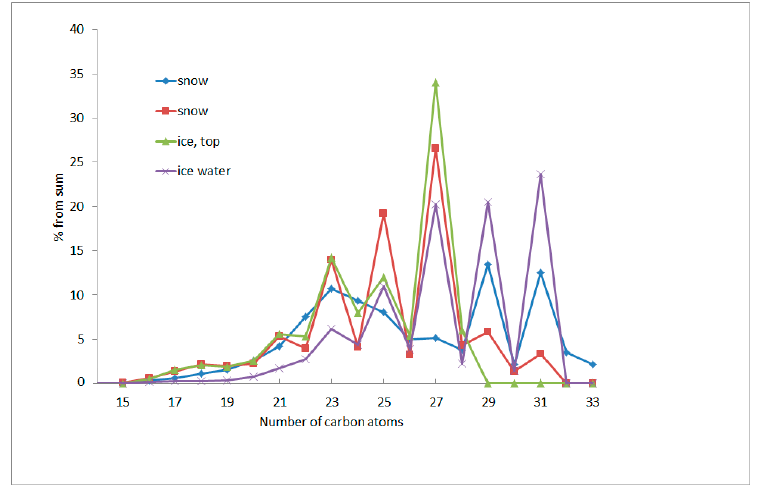
Figure 7. Composition of the alkane in snow, ice, and ice water of Pikalevo Lake, 2017.